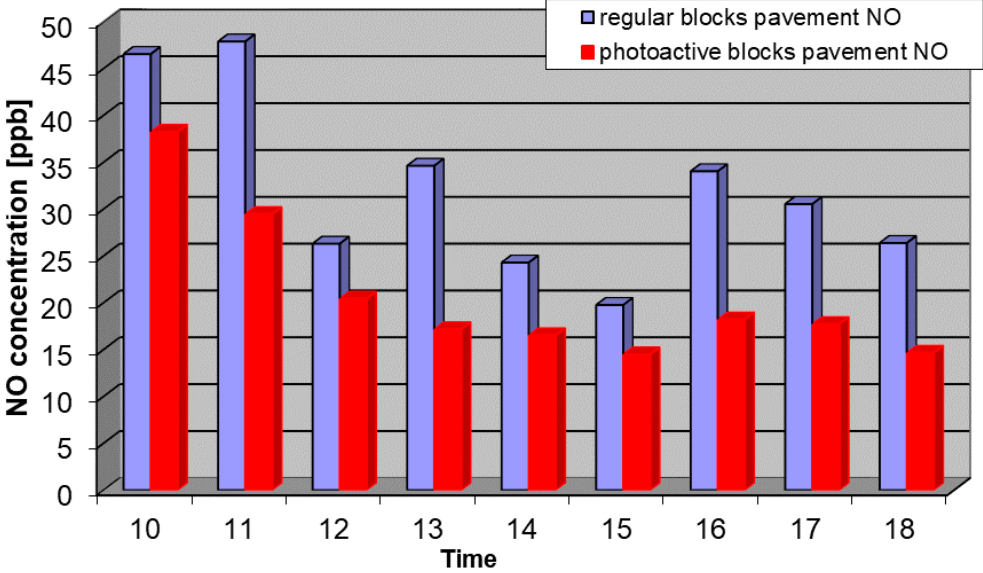
Figure 6. Average concentration of NO on 12 September, 2018 from 10 a.m. to 6 p.m. at the regular pavement (blue) and photocatalytic pavement (red).